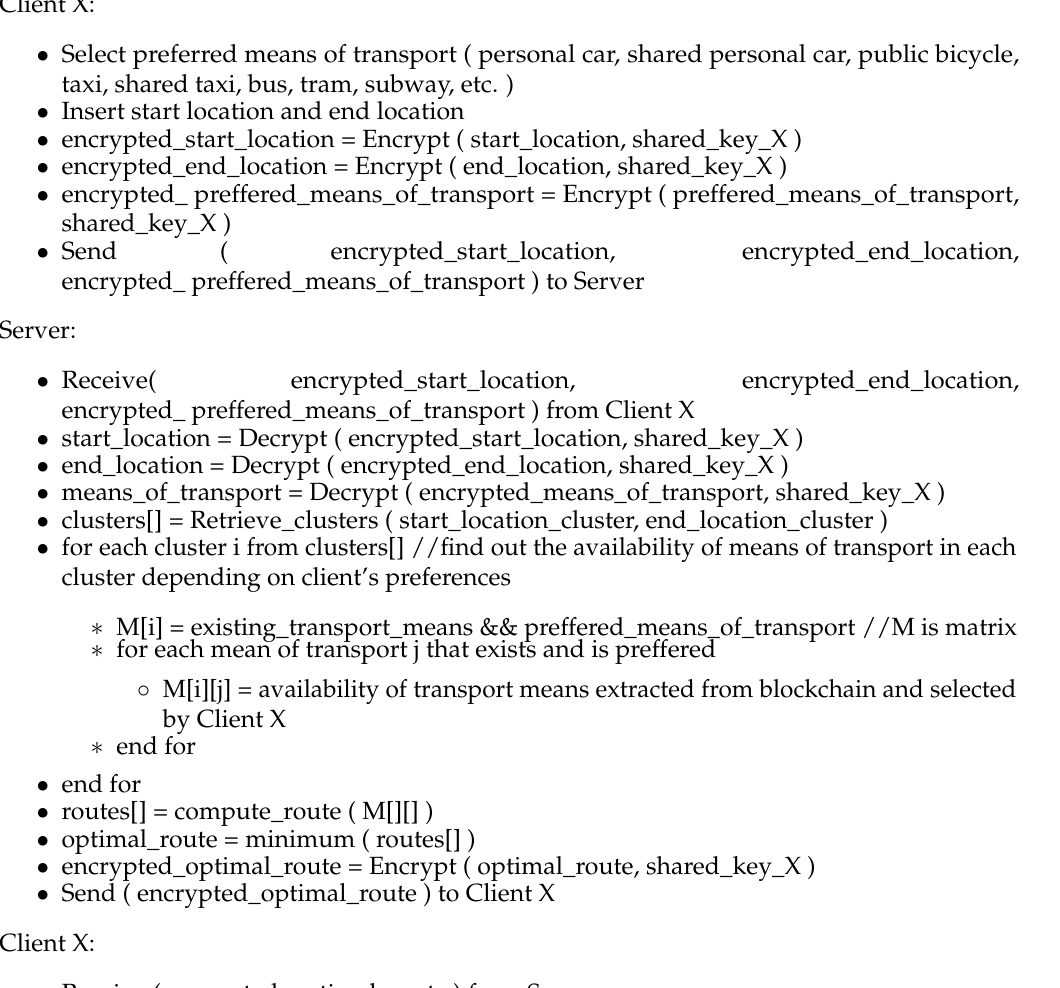
Algorithm 2 Optimal route